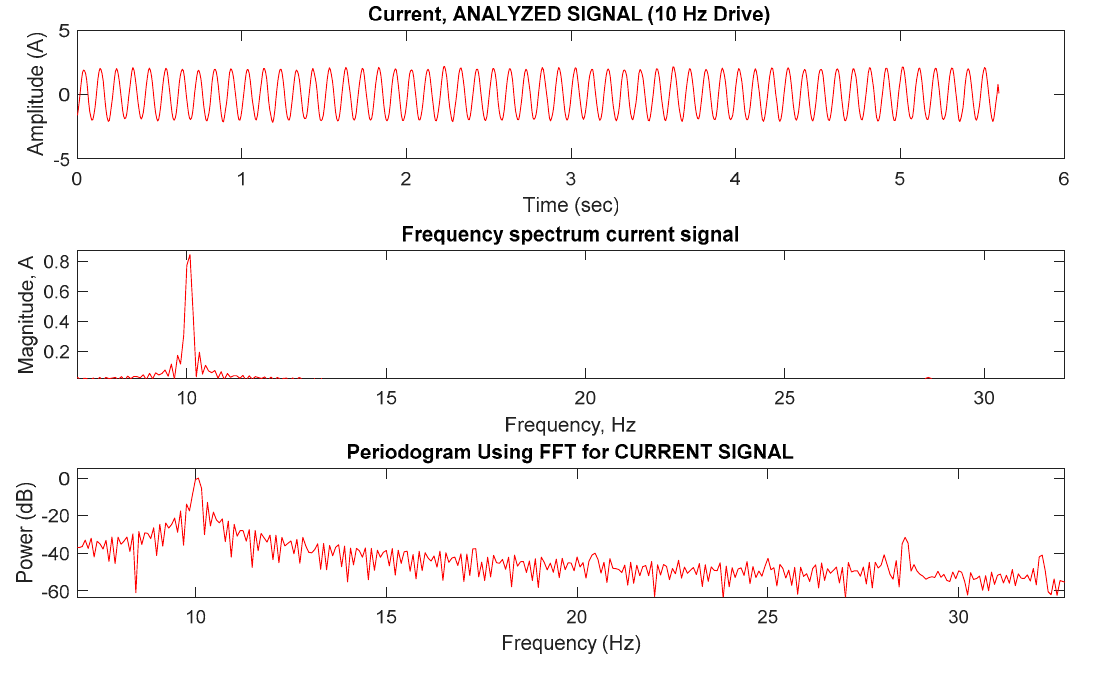
Figure 12. FFT analysis of current signal measurement of motor line current of phase A, frequency spectrum, and periodogram at 20 Hz speed operation.